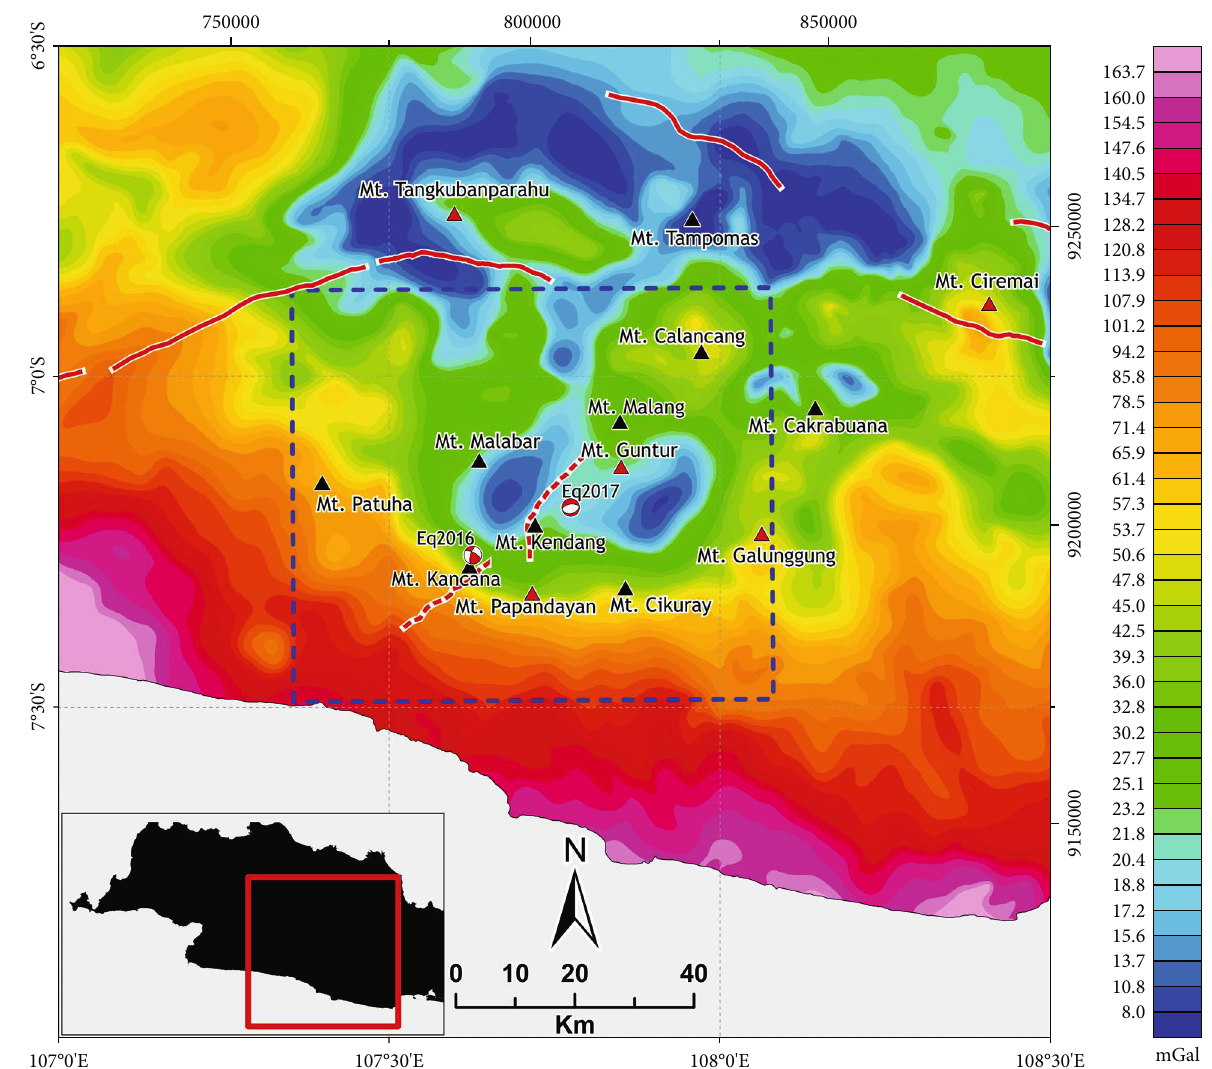
Figure 3: The Bouguer anomaly map of southern Garut and its surroundings from [35] covering a larger area beyond the interest area (dashed blue outline) to estimate the regional anomaly component. Active faults (full red line) and possible active faults (dashed red line) are from [3]. Black and red triangles represent dormant and active volcanoes,